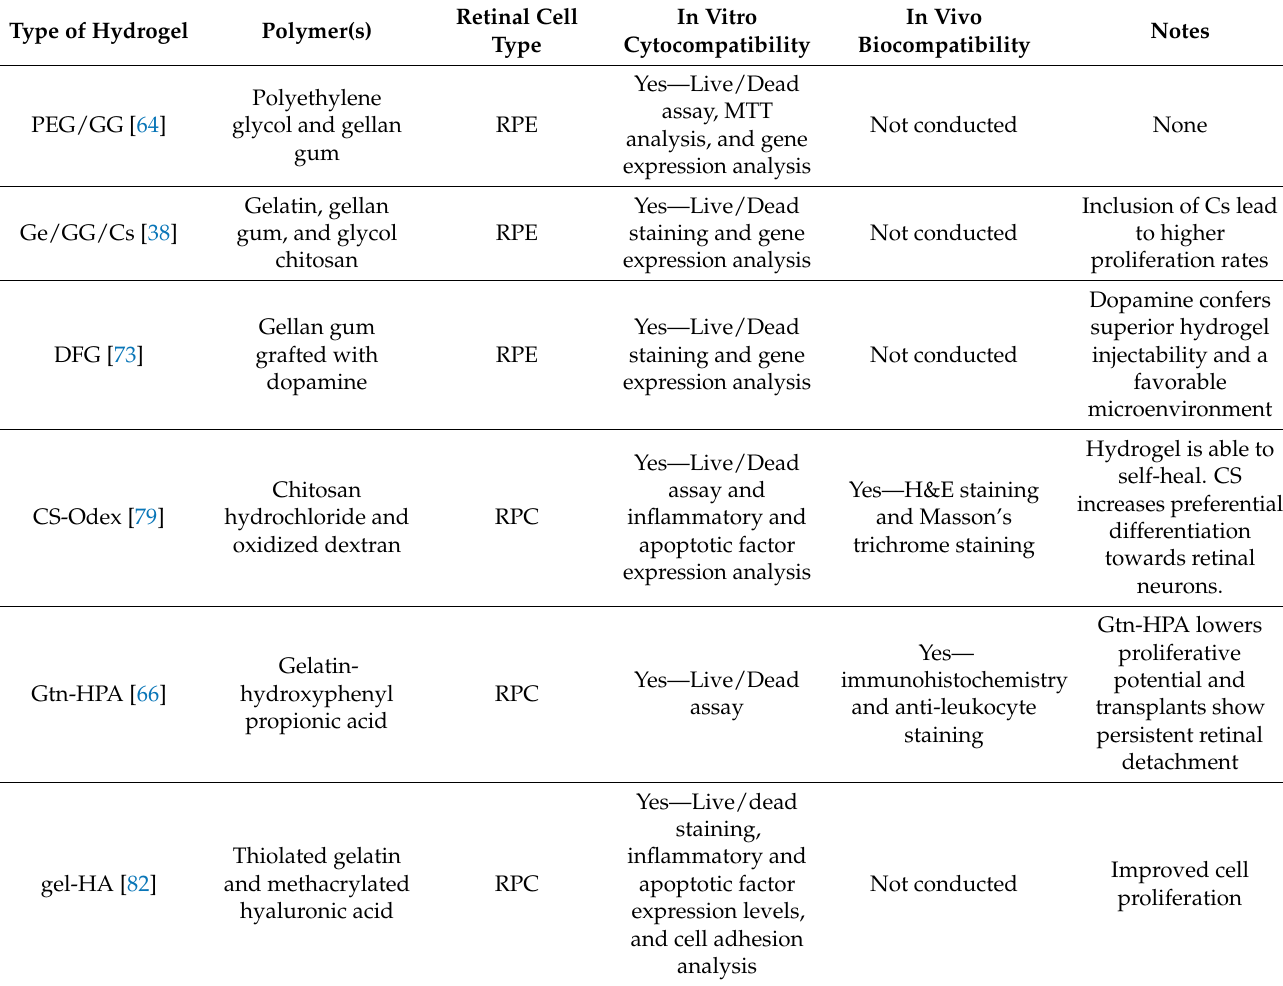
Table 1. Summary of hydrogels investigated for stem cell delivery and